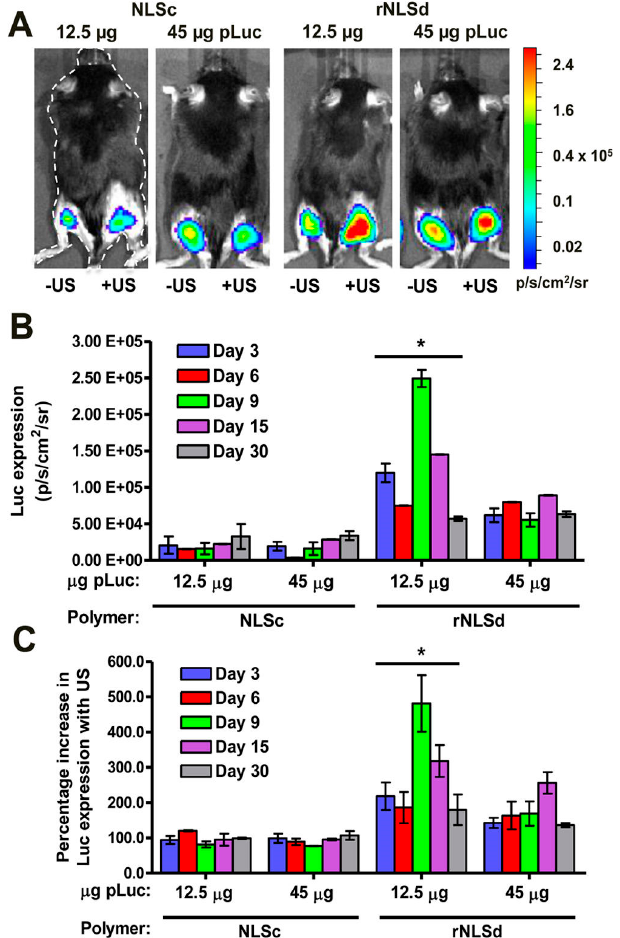
Figure 4. Intramuscular ultrasound-mediated gene delivery or “sonodelivery” in mice by NLSc- and rNLSd-based polyplexes. ( A ) Representative bioluminescence images of mice transfected with a luciferase reporter plasmid after a 5 min acquisition time using a Xenogen IVIS100 CCD camera (9 days after sonoporation). The right hind legs represent protein expression resulting from intramuscular ultrasound-mediated delivery; the left hind legs represent intramuscular delivery in the absence of ultrasound. The color bar indicates the luminescence intensity in photons per second per square centimeter per steradian (p / s / cm 2 / sr). ( B ) Luciferase expression from right hind legs. ( C ) Percentage change in luciferase expression upon application of an ultrasound stimulus (the ratio of the expression from the right hind leg to that from the left hind leg). Bars indicate ± the standard error of the mean (error bars) with * p < 0.05 for the rNLSd 12.5 µ g dose as compared to all other groups. (Reprinted with permission from Parelkar et al. [17]. Copyright (2014) American Chemical Society.)